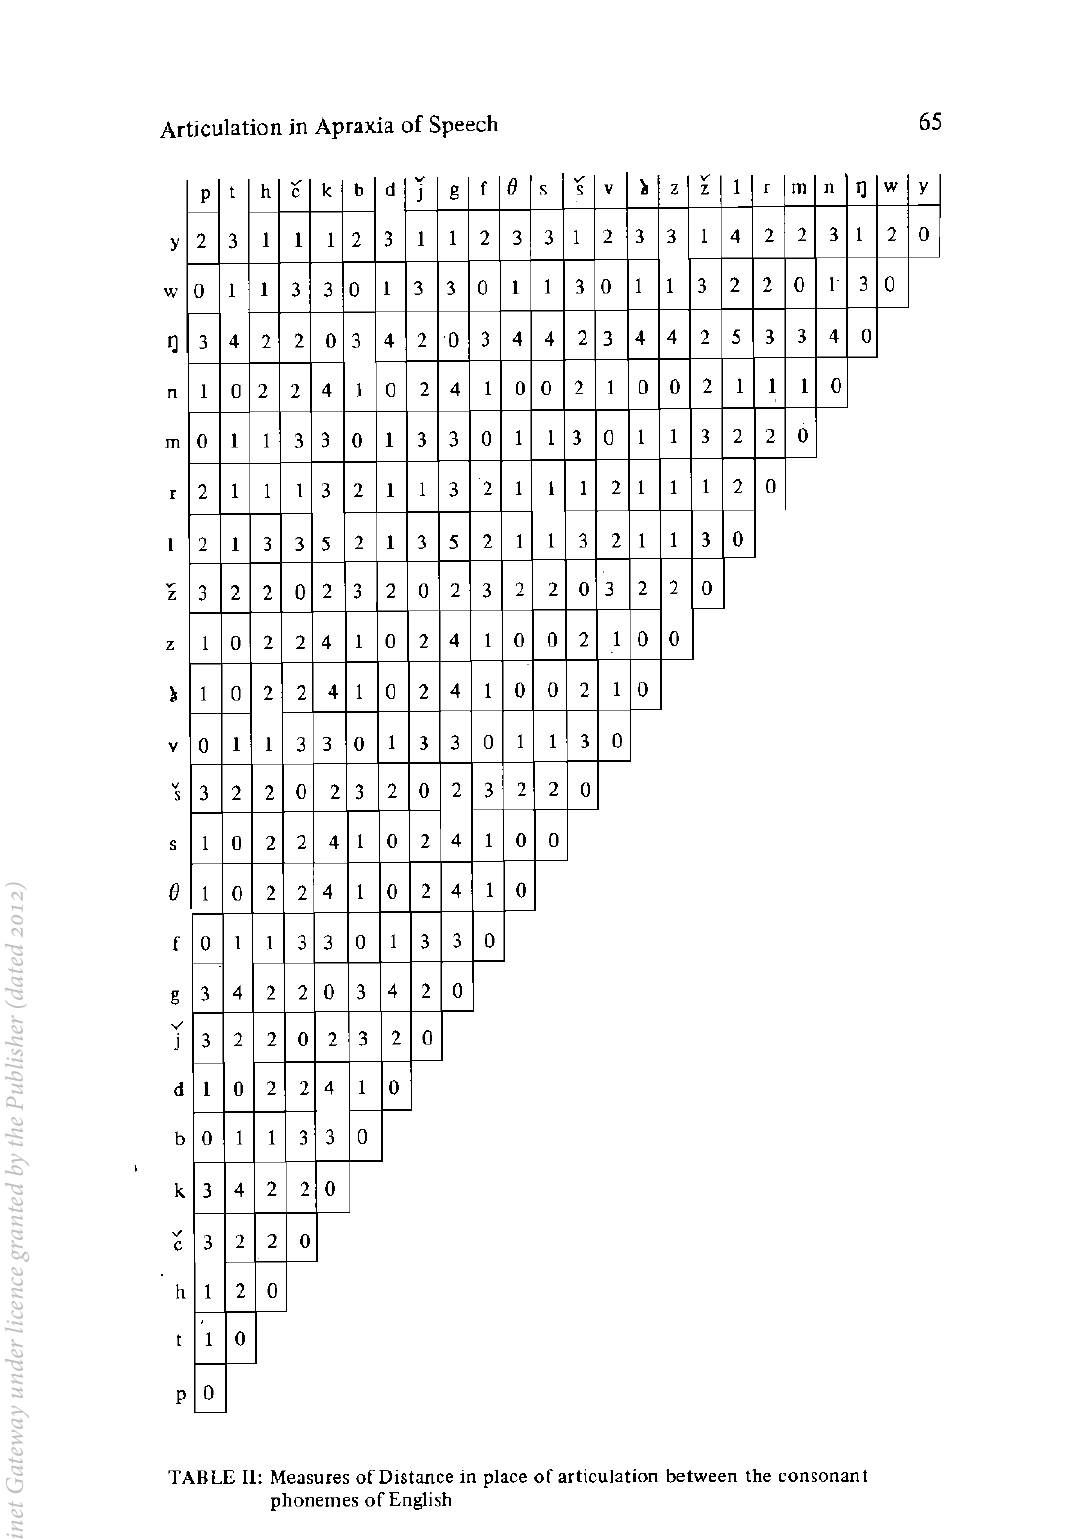
TABLE II: Measures of Distance in place of articulation between the consonant phonemes of English Tydskrif van die Suid-Afrikaanse Vereniging vir Spraak- en Gehoorheelkunde, Vol. 23. Desember